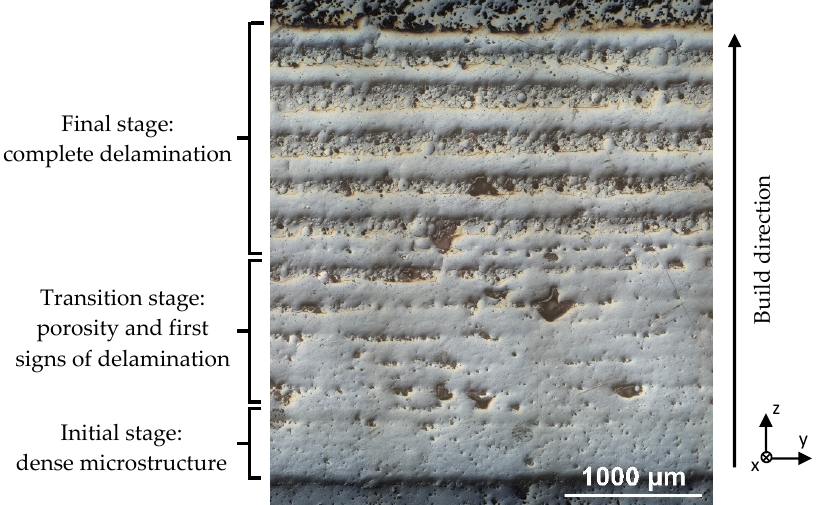
Figure 12. Cross-section of a tensile bar. The build (Z) direction runs from bottom to top, the layer application (X) direction is normal to the viewing plane.